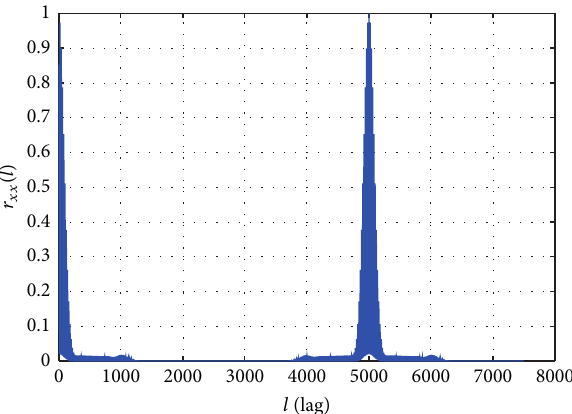
Figure 4: Normalized autocorrelation coefficients of example